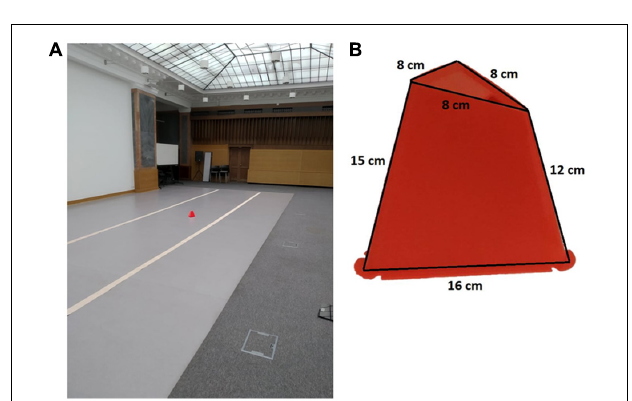
FIGURE 2 | Participants’ verbal (A) and non-verbal responses (B) in Experiment 1 Superimposed distributions show responses in different weight conditions under which individual data points are vertically jittered. Boxes indicate interquartile range with median, whiskers show 1.5 interquartile range (modified from Allen et al., 2019).